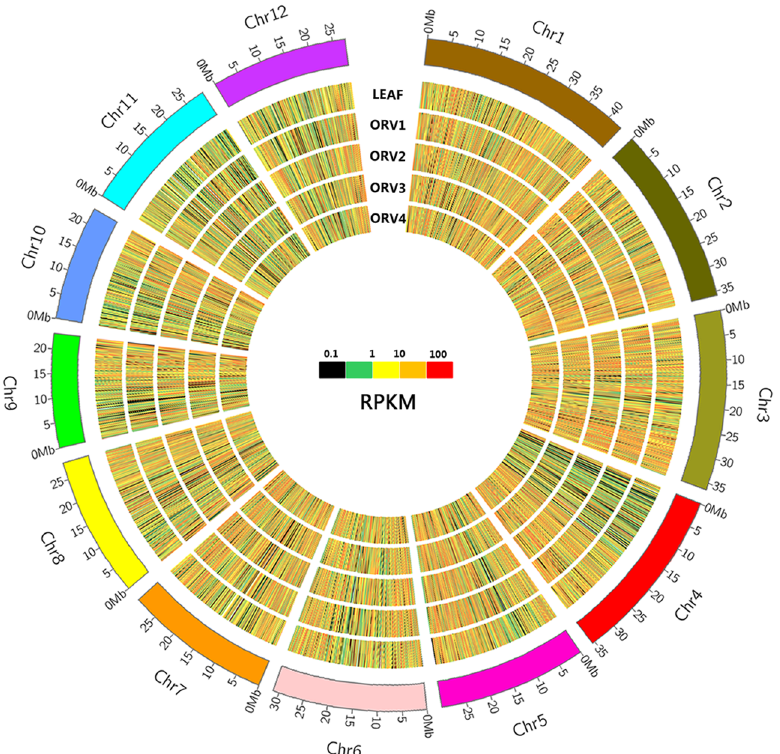
Fig 2. Circos diagram depicting the gene expression in leaf and ovules of four developmental stages. In this figure, the entire rice chromosomes were displayed by the first outer ring. Five concentric rings represented the five samples (LEAF, OVR1, OVR2, OVR3, OVR4), respectively. Colors represented (from black to red) the expression levels of all detected transcripts in every sample based on the RPKM